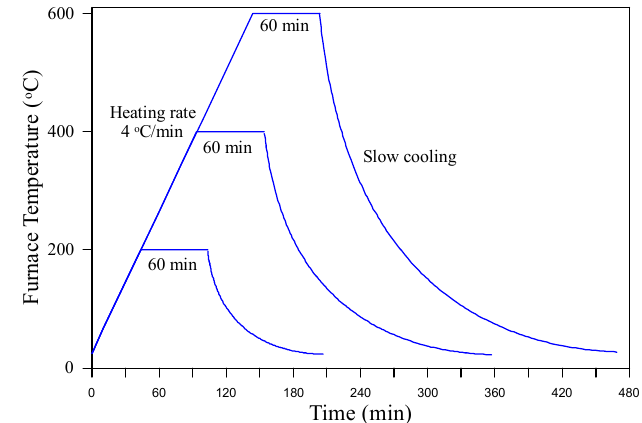
Figure 3. Temperature–time curve of the heating process.